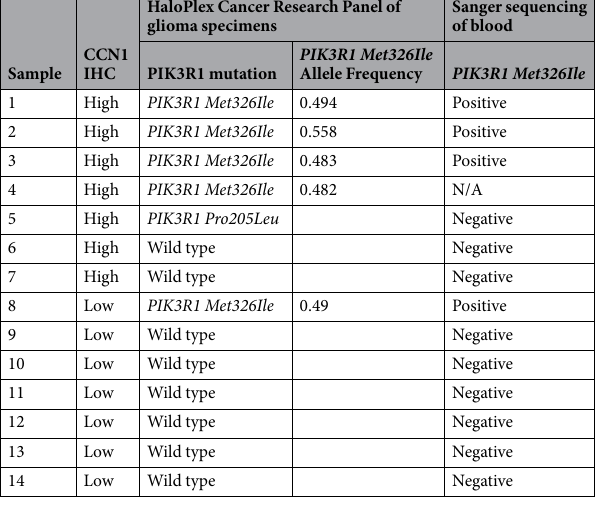
Table 1. The results of HaloPlex Cancer Research Panel analysis of glioma specimens and Sanger sequencing of corresponding blood samples for the PIK3R1 germline mutation IHC = immunohistochemistry; N/A = not available.